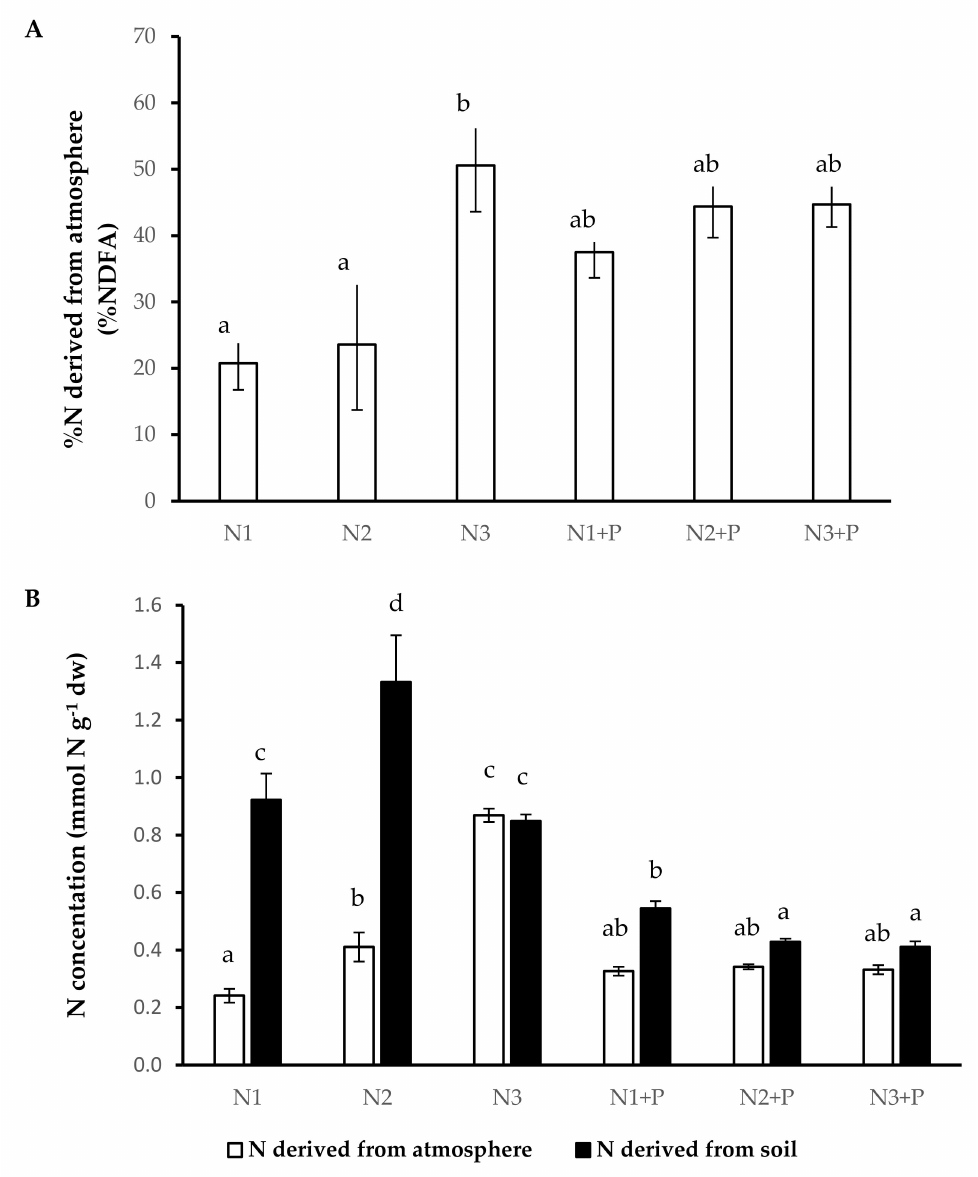
Figure 3. N source preferences (( A ). Percentage N derived from the atmosphere, ( B ). Plant N concentration derived from atmosphere and Plant N concentration derived from soil) of 180-day-old V. nilotica saplings grown in Ukulinga Farm soils. Values represent the mean ± SE, based on n = 5. Significant differences ( p < 0.05) among treatments are denoted by different superscript